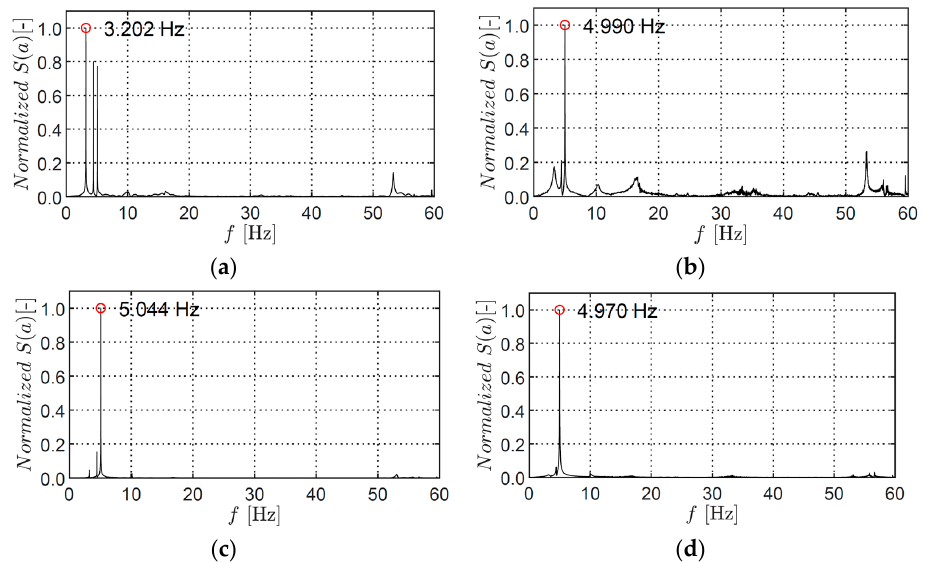
Figure 18. FFTs of dominant coupled responses from Setup 2: ( a ) vertical response at U = 0 m/s; ( b ) vertical response at U = 10 m/s; ( c ) torsional response at U = 0 m/s; ( d ) torsional response at U = 10 m/s.